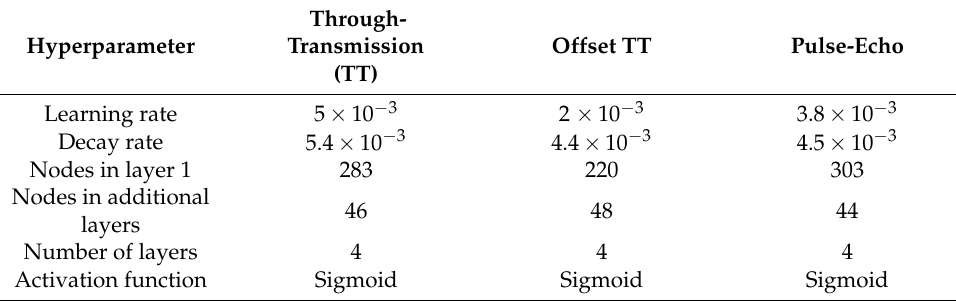
Table 1. DNN hyperparameters selected from stochastic optimisation.